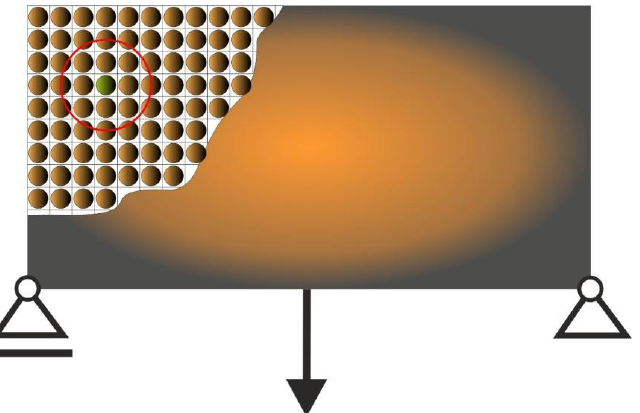
Figure 1. The cell lattice. A body is placed in each cell. The neighborhood, which is represented by the red circle, is identified around each body/cell.